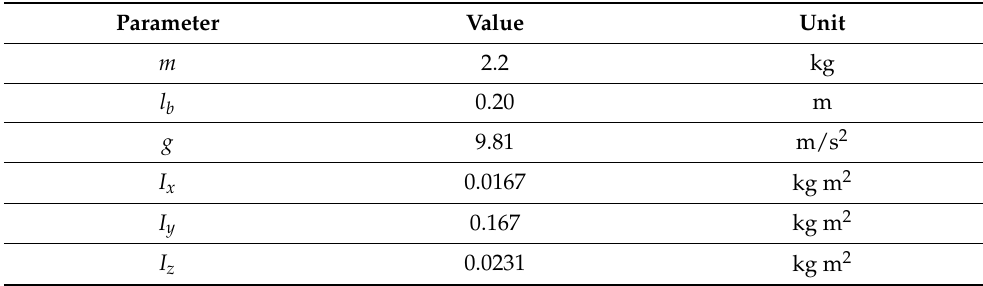
Table 1. Physical parameters of the